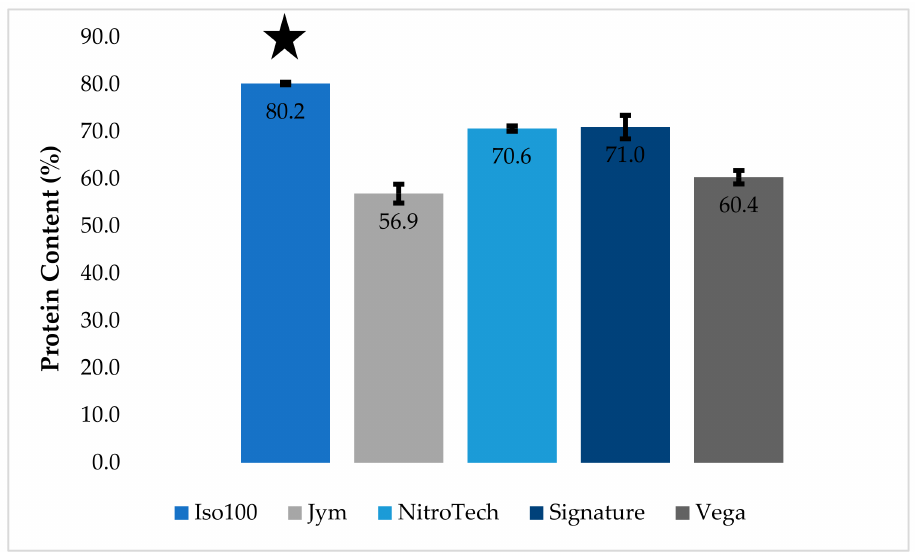
Figure 2. Bar graph of mean percent protein for five protein powder products, 2.0 g sample size. Star represents the significant difference between ISO100 and the other protein powders. Standard deviation is shown for each sample, where the error bar is based on a sampling size of 14 measure- ments (standard error of means (SEM)). = ISO100 protein powder, = JYM protein powder, = NitroTech protein powder, = Signature protein powder and = Vega protein